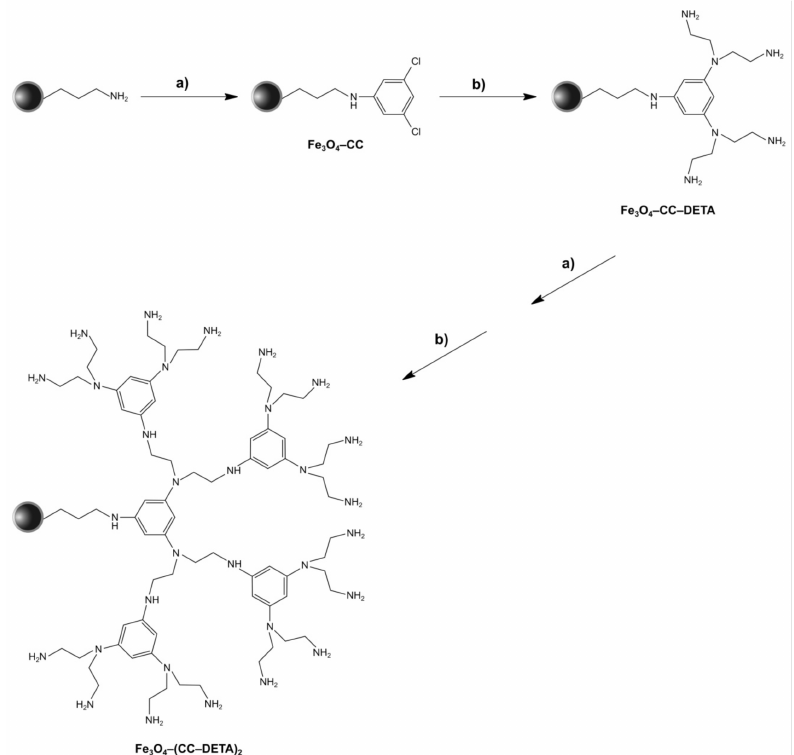
Figure 1. The synthetic protocol for obtaining the triazine dendron-functionalized magnetite nanopar- ticles as an introduction of cyanuric chloride (CC) and diethylenetriamine (DETA) to the surface of